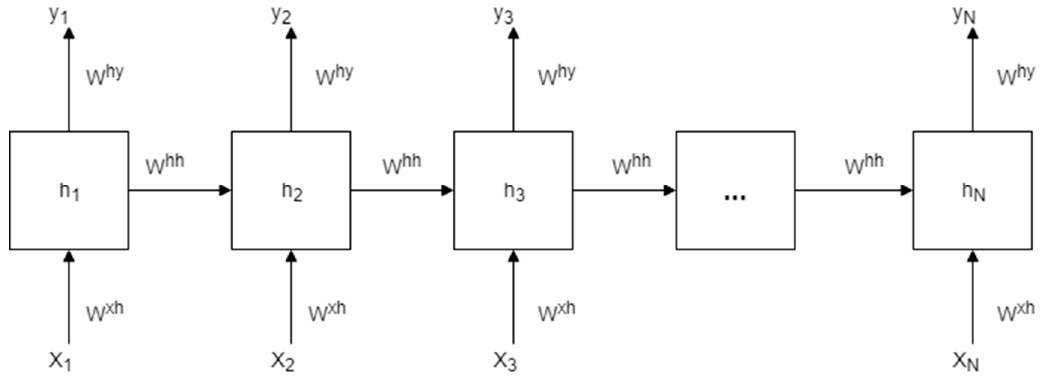
Figure 2. An unrolled recurrent neural network.